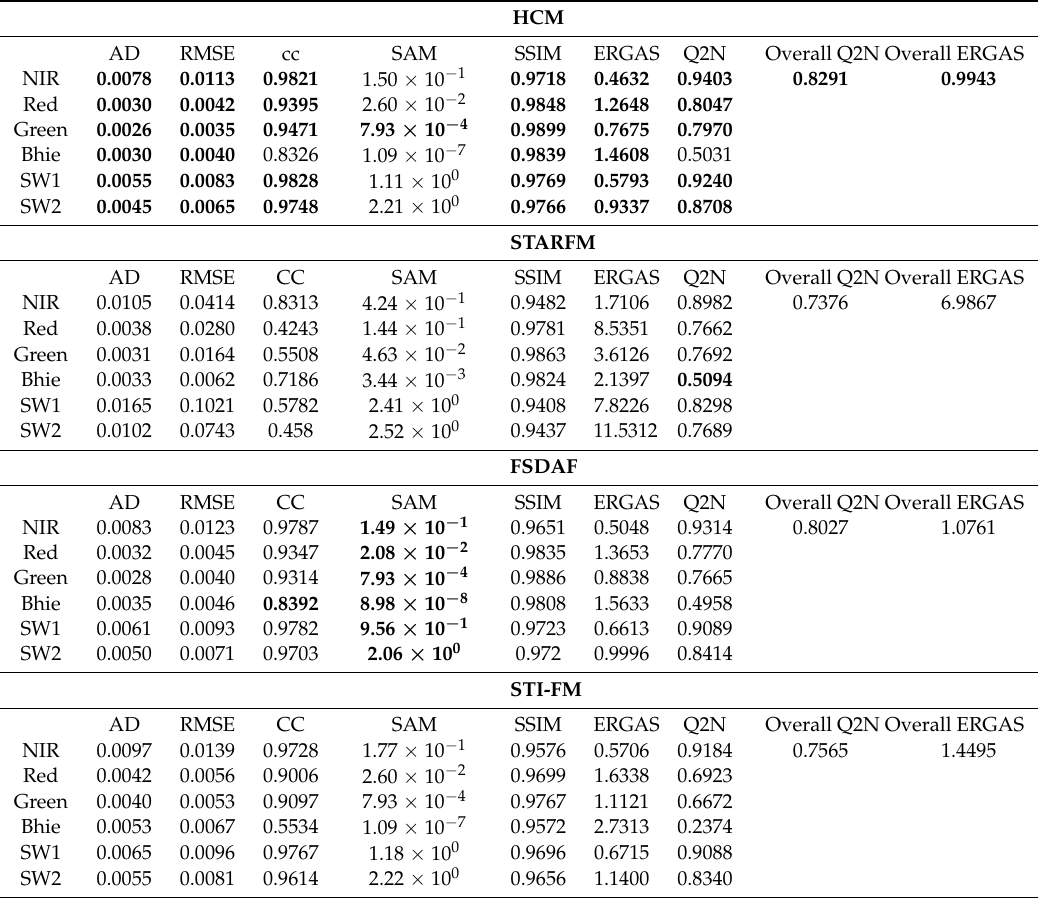
Table 4. Comparison of forward prediction results of using Landsat image 192 to predict Landsat image